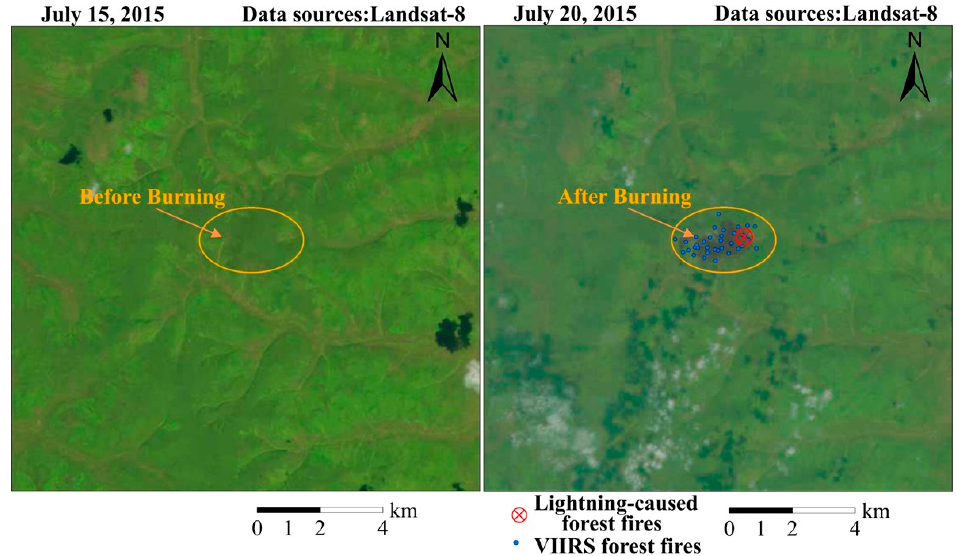
Figure 9. Comparison of true color images before and after lightning-caused forest fires on 17 July 2015.